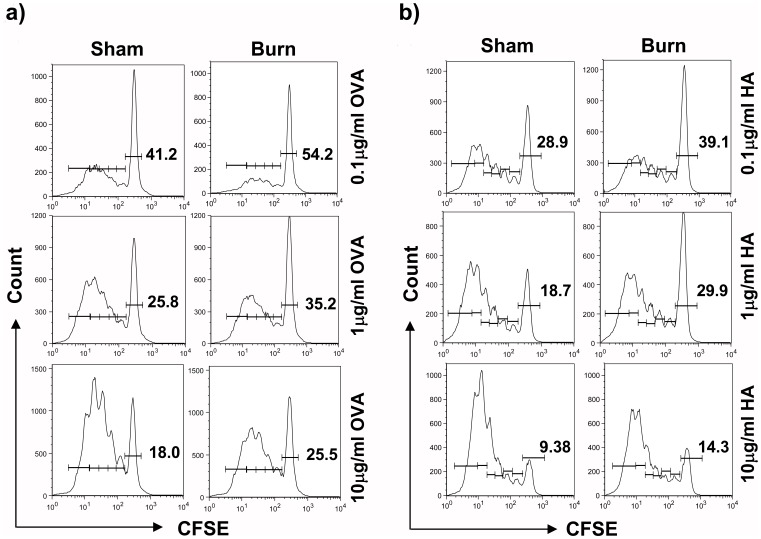
TLR9-activated pDCs from burn-injured mice had a reduced ability to activate CD4+ and CD8+ T cell proliferation.Three days post-injury, FACS-sorted splenic pDCs were pulsed with either OVA323-229 class II or HA class I-restricted peptides (concentration ranging from 0.1 to 10 µg/ml) and activated with CpG (6 µg/ml, 18–20 hr). CFSE-labeled OVA-specific CD4+ and HA-specific CD8+ T cells were co-cultured with the washed, activated pDCs for three consecutive days. Proliferation of (a) CD4+ and (b) CD8+ TCR-transgenic T cells is illustrated by means of CFSE dilution measured using flow cytometry. Representative FACS plots are shown and percentages of unproliferated cells were gated (n = 9, 3 independent experiments).